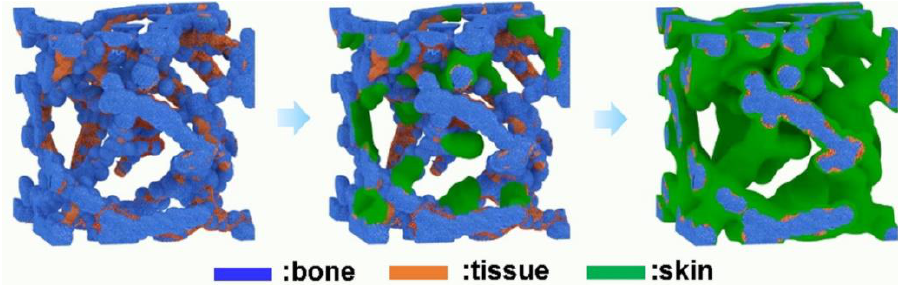
Figure 39. Schematic representation of the skin-tissue-bone like structure (reproduced from the work in [85] with permission). in [85] with